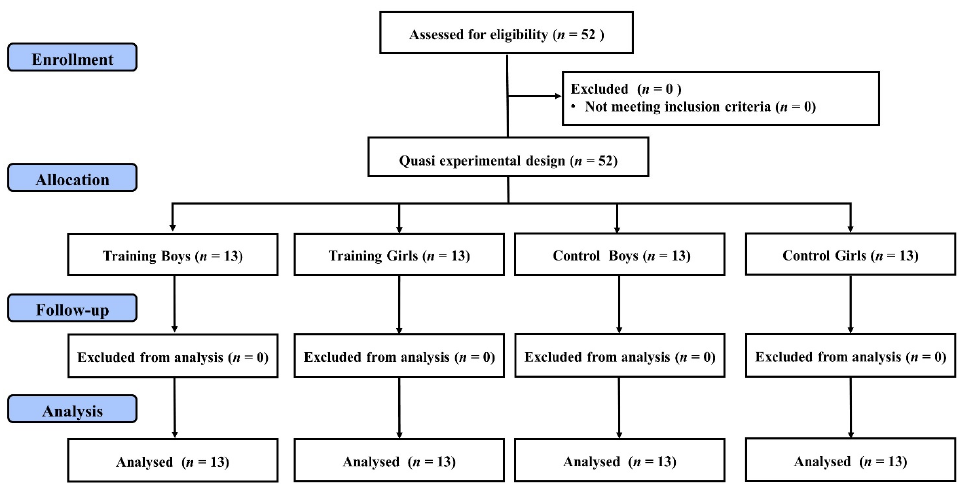
Figure 1. Experimental flow diagram of the study.